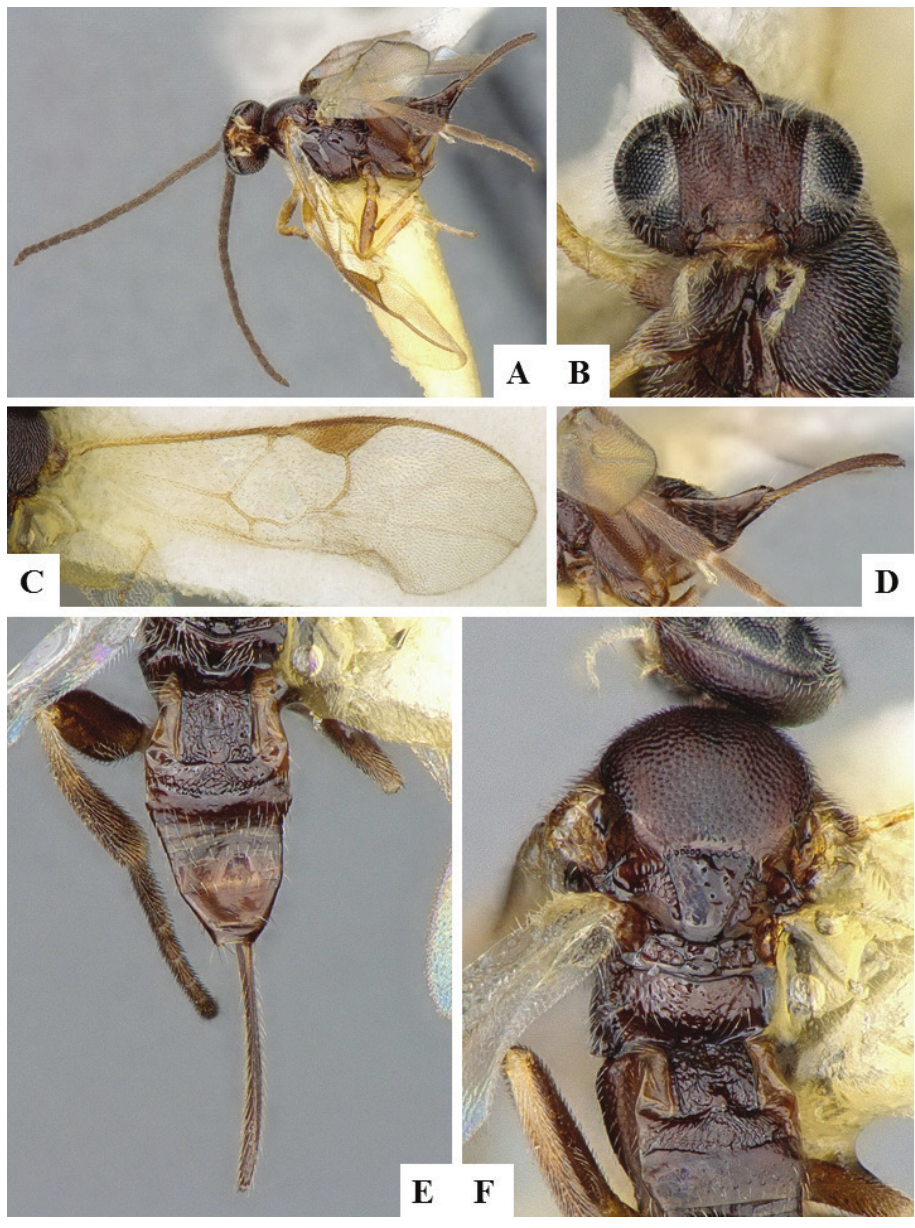
Figure 24. Dolichogenidea thujae. A Habitus, lateral B Head, frontal C Wings D Ovipositor sheaths and ovipositor E Metasoma, dorsal F Head and mesosoma,